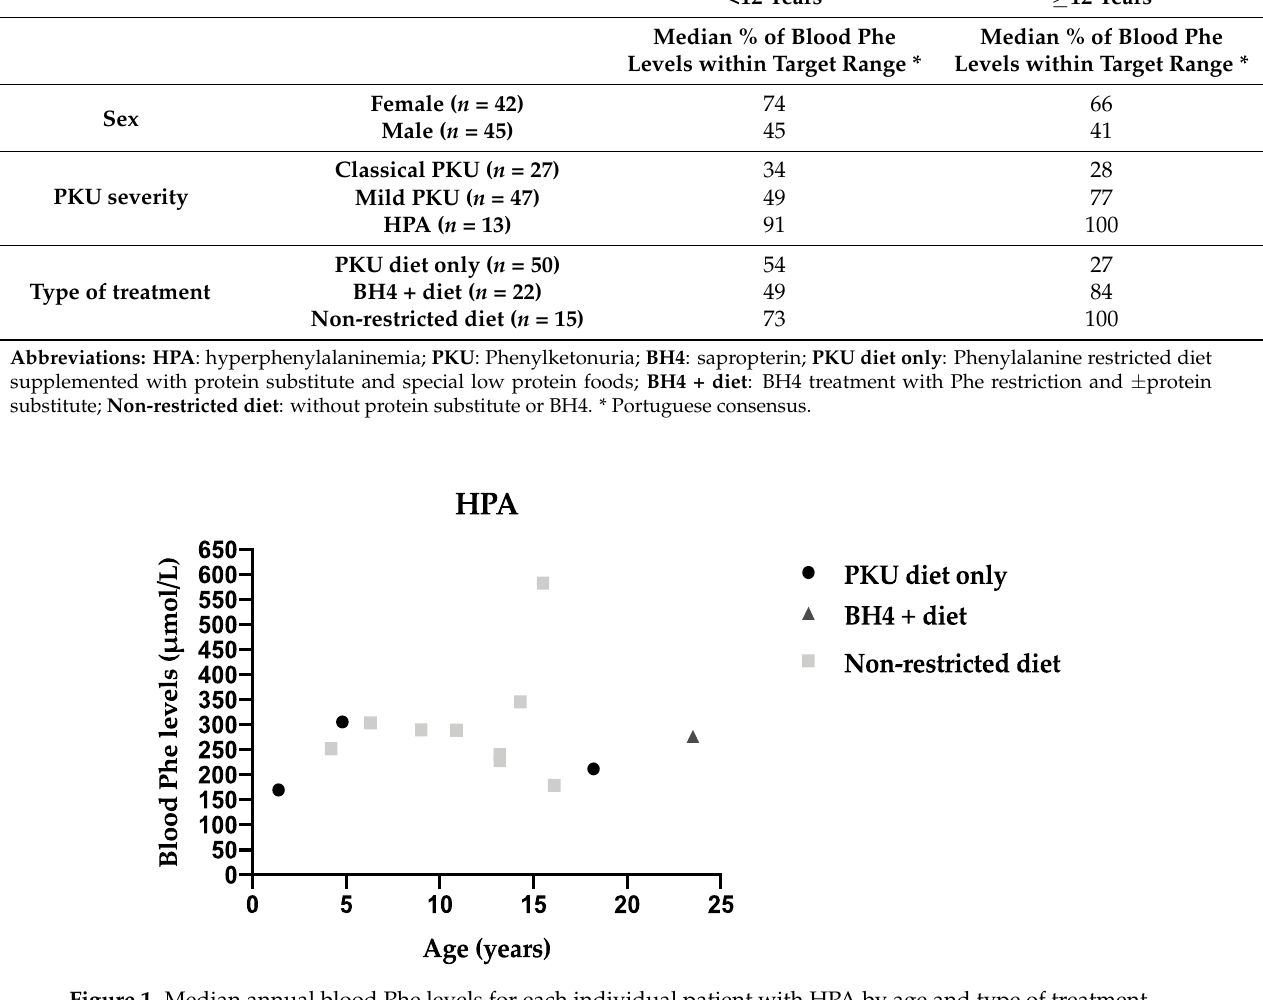
Figure 1. Median annual blood Phe levels for each individual patient with HPA by age and type of treatment.